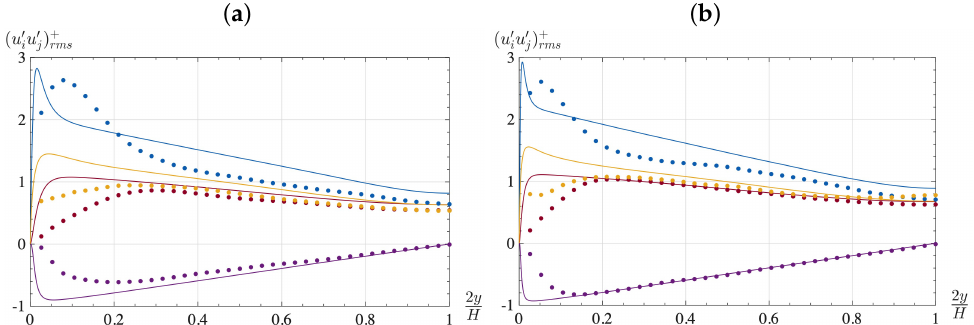
Figure 4. Statistics of velocity fluctuations, in turbulent channel flow simulations with: (bullets) the pLBM-LES model with the wall model and N = 40, and (lines) the DNS model of [38], for Re m = ( a ) 37,042, and ( b ) 87,000. The scaled root-mean-square ( rms ) of products of velocity fluctuations, (cid:113) ( u (cid:48) ) + = u (cid:48) u (cid:48) u (cid:48) / u τ is plotted as a function of the distance from a plate for: ( i = j = 1 ) ( • ), rms i j i j ( i = j = 2 ) ( • ), ( i = j = 3 ) ( • ), and ( i = 1, j = 2 ) ( •